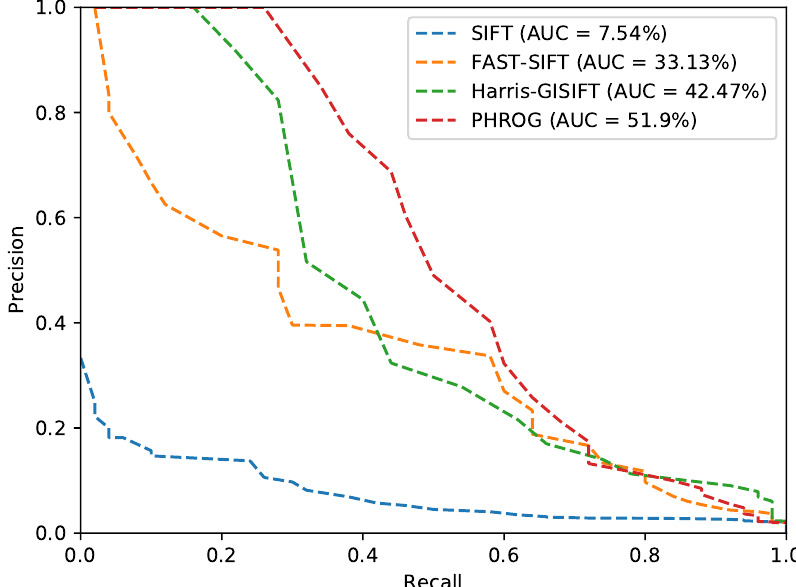
Figure 15. Precision-Recall curves from the “street” dataset and AUC ( Area Under the Curve ) for each